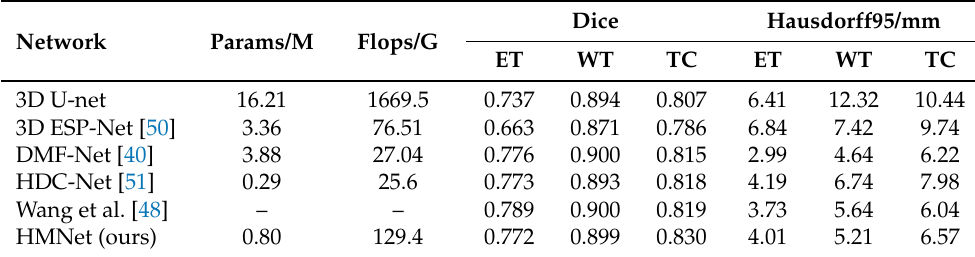
Table 10. Comparison with other brain tumor segmentation networks on the BraTS 2019 validation set. Here, (–) denotes that the results are not